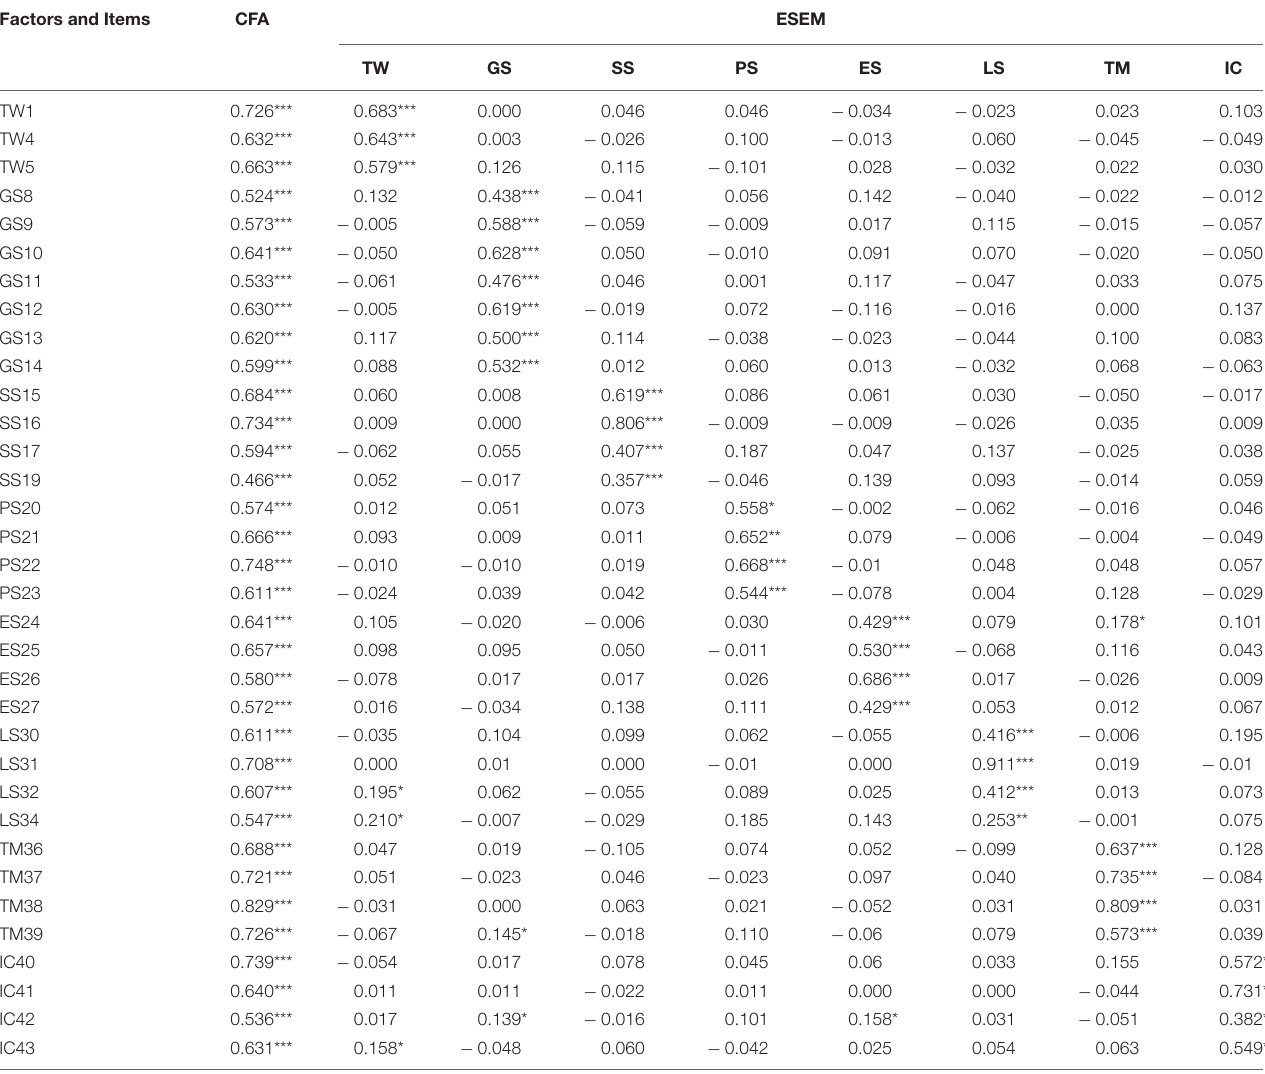
TABLE 5 | Standardized factor loadings for the re-specified model of the life skills scale for sport. Factors and